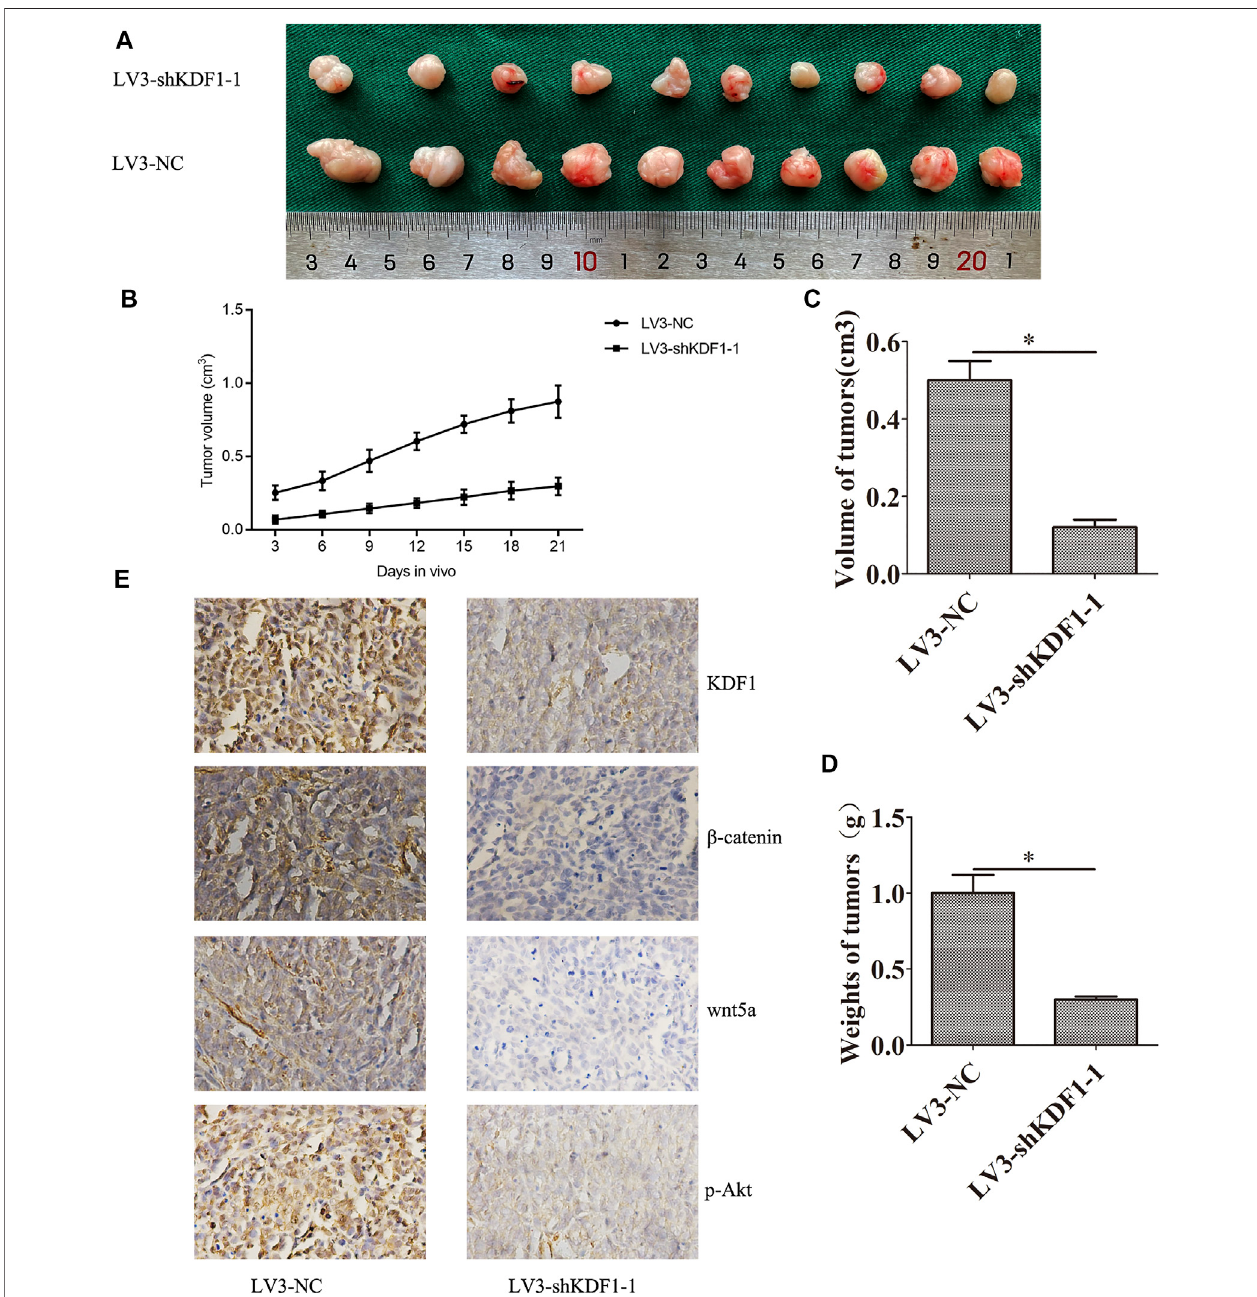
FIGURE 7 | Silencing KDF1 inhibited SKOV3 cells ’ growth in vivo . The picture of xenograft in two groups (A) : the growth curve of tumor in two groups (B) , the volume of tumor in different groups (C) , the weight of tumor in different groups (D) , and the expression of KDF1, Wnt5A, p-AKT, and β -catenin was detected by immunohistochemistry (E) . Error bars represent the standard error. *indicates p < 0.05.